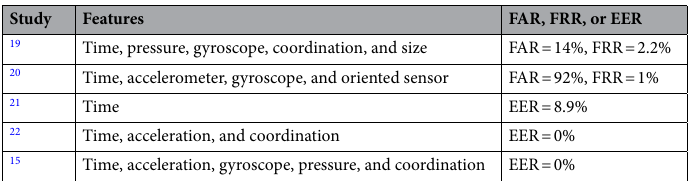
Table 1. Summarized studies on free KDA for touch